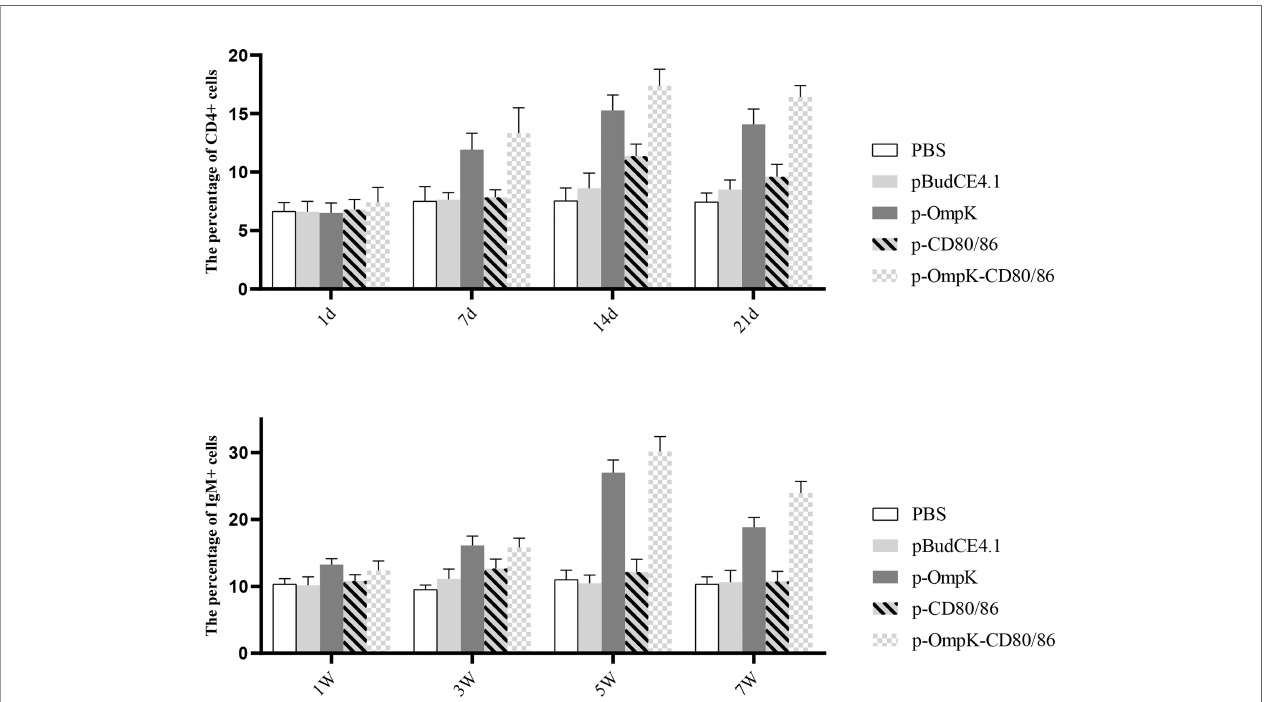
FIGURE 7 | Analysis of the expression pro fi les of immune-related genes in the muscle around the injection site at the 3rd and 7th day post-immunization detected by qRT-PCR. The expression levels of cytokines IL-2, TNF- a , and IFN- g ; T-cell membrane-bound molecules CD4, CD8, and CD28; and antigen-presenting molecules CD83, MHCI, and MHCII were monitored. The relative expression levels were normalized against b -actin and expressed as fold change compared with the PBS-stimulated group at 72 h and 168 h poststimulation. Data were presented as the means ± SD of three fi sh, and the different letters on the bars indicate the statistical difference ( p < 0.05) between the experimental and control group at the same time